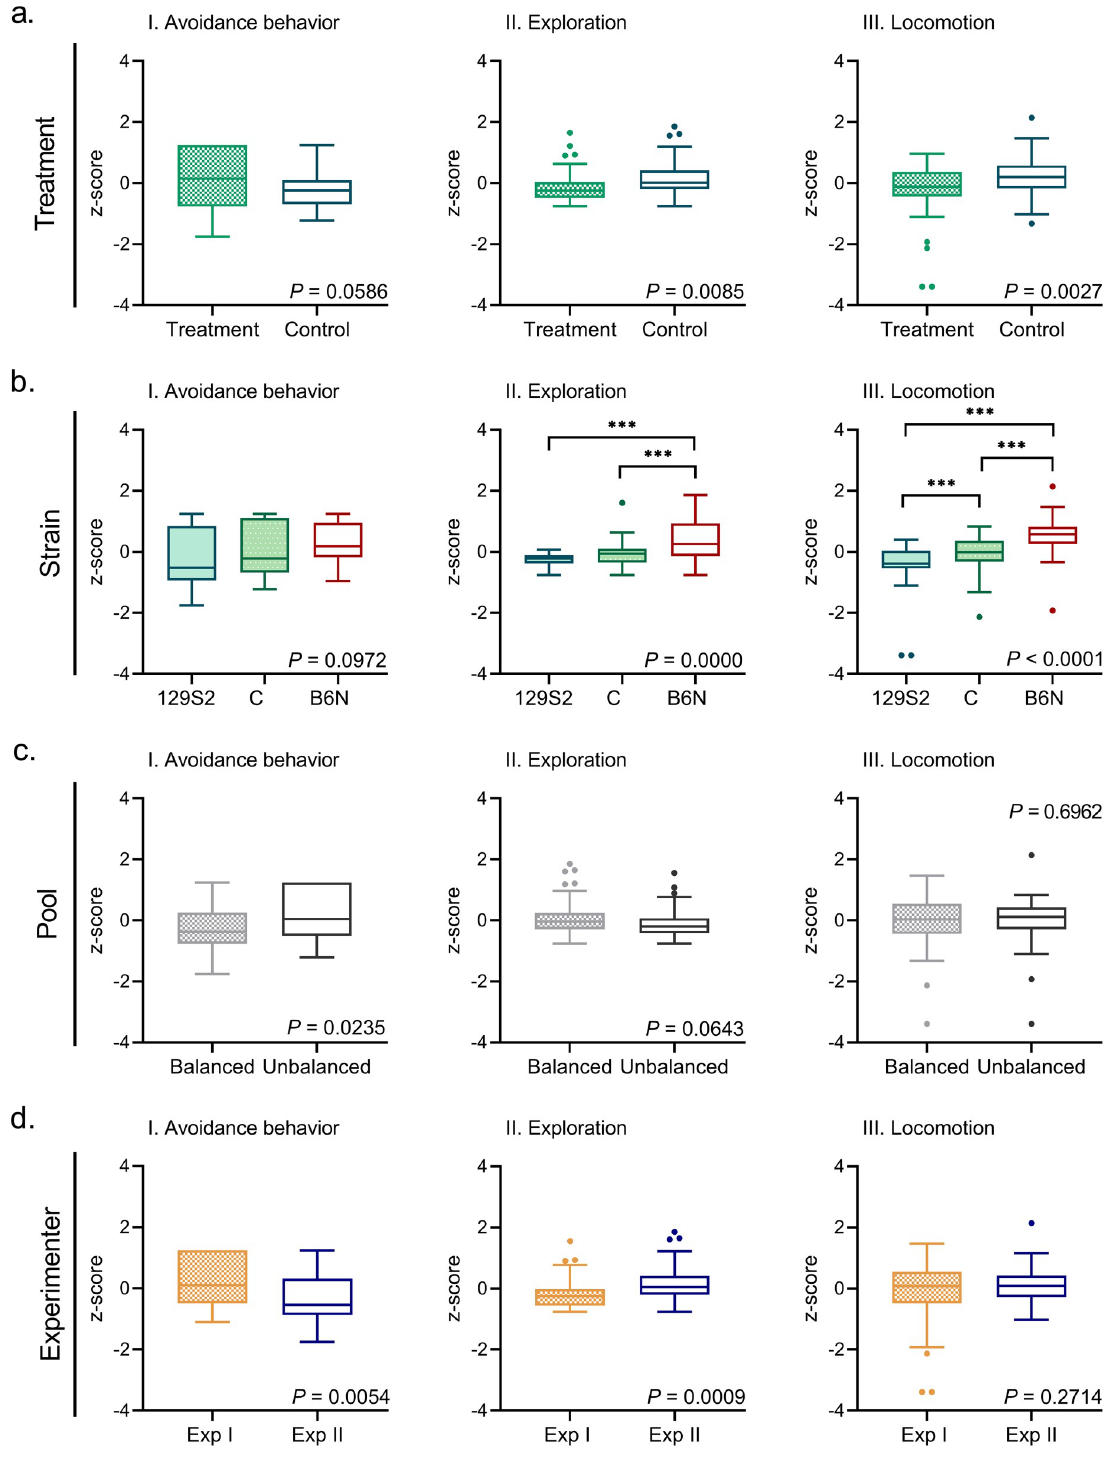
Fig 5. (a-d) Avoidance behavior, exploration and locomotion of mice in a single 5-minute mHB trial. Behavior in all graphs expressed as integrated behavioral z-score. Results are presented as boxplots (median, upper and lower quartiles) with Tukey whiskers. Individual points = outside the upper/lower quartile � 1.5 inter-quartile range. Effects were significant in GLMs at P < 0.05. Significant differences in post hoc contrasts between strains (adjusted α = 0.02532) are indicated by ��� when P < 0.00050. The raw integrated z-scores (mean ± 95% CI) of each group depicted in this figure are presented in S5 Table.